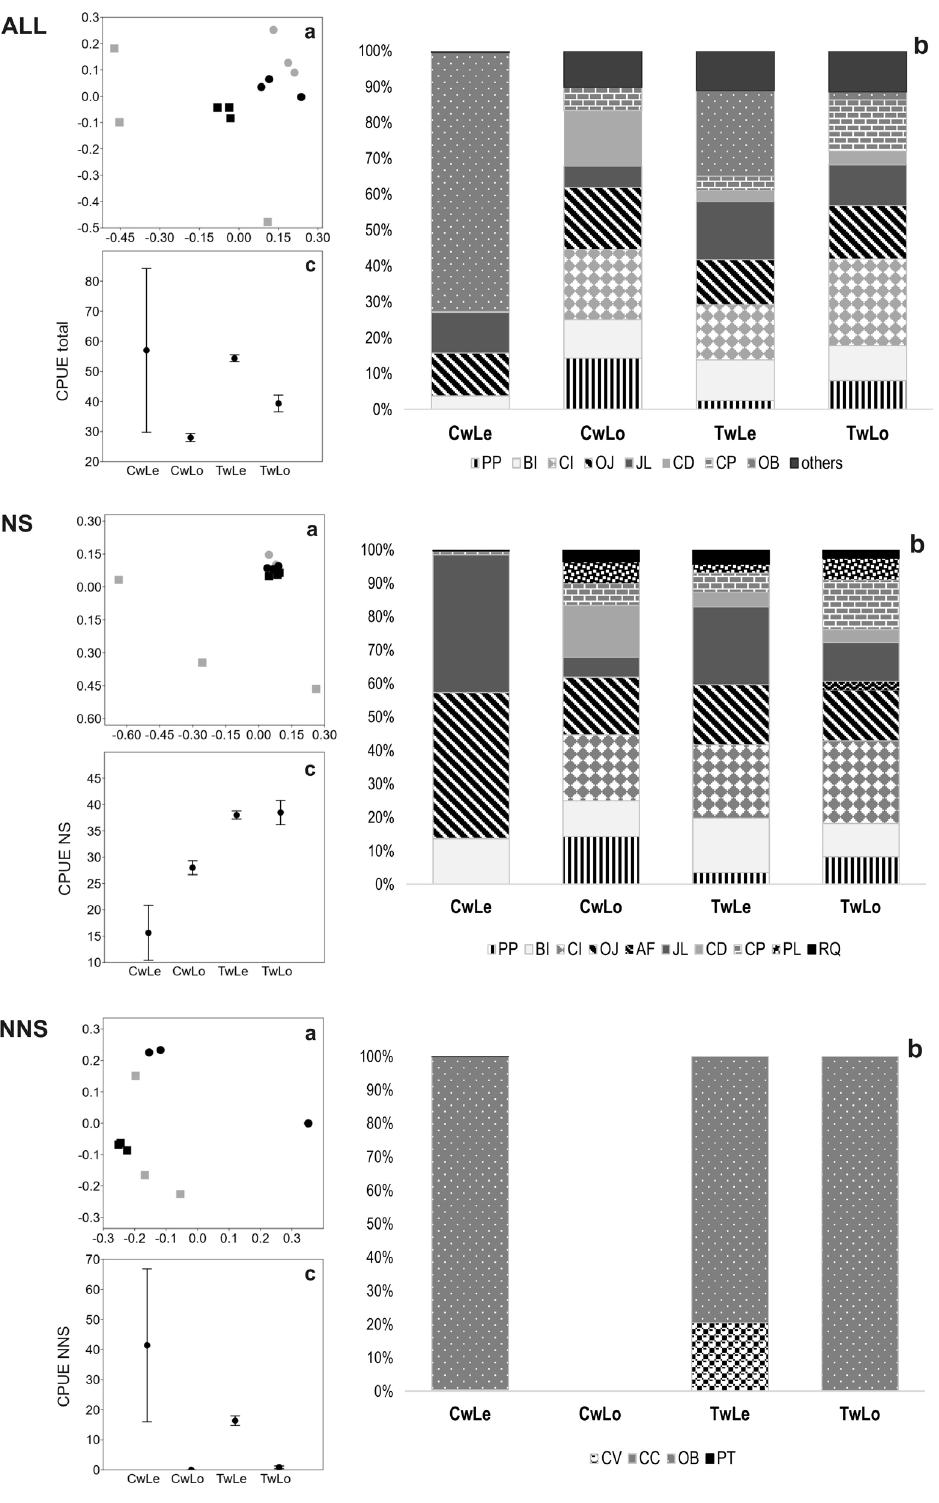
Figure 4. (a) Non-metric multidimensional scaling of the abundances of all fish species (ALL), only native species (NS) and only non-native species (NNS) in sampled sites (CwLe = clear water lentic conditions; CwLo = clear water lotic conditions; TwLe= turbid water lentic conditions; TwLo = turbid water lotic conditions) of the Sauce Grande River (lentic sites: squares, lotic sites: dots; CwLe = gray square; CwLo = gray dot; TwLe = black square; TwLo = black dot); (b) Percentage contribution of specific abundances for the same three data sets (ALL, NS and NNS). The species codes as listed in Table 2. “Others” category in abundances of all fish species (ALL) corresponds to species whose abundance was less than 6.5% at all sites; (c) Mean abundances and standard deviations of fish species for the three data